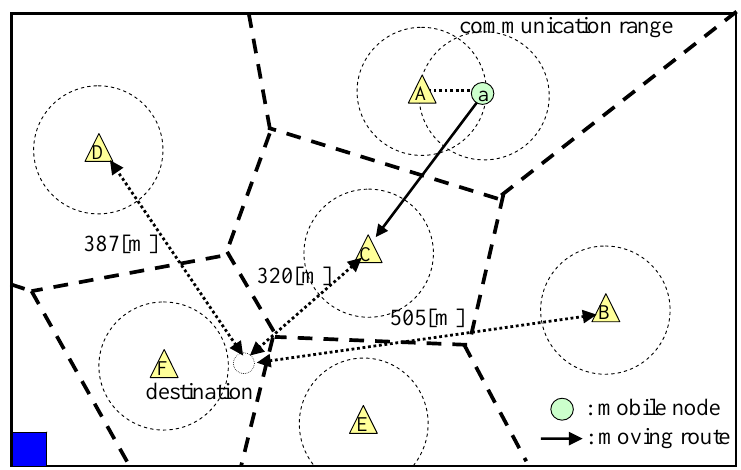
Figure 3. Moving route of a mobile